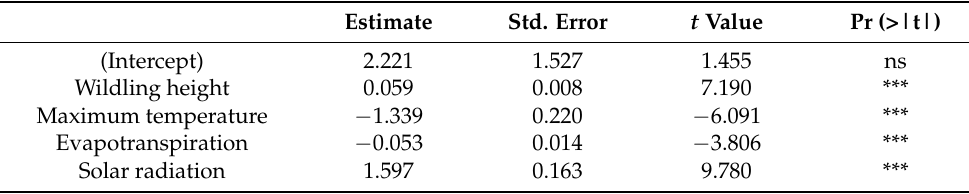
Table 2. Generalized linear mixed model presenting the effect of wildling height, maximum daily temperature, evapotranspiration and solar radiation on wildling growth (cm month − 1 ). The table shows the coefficients of the model, the respective standard errors, the z statistic and the associated probabilities: ≤ 0.001 = ***; >0.05 = ns.